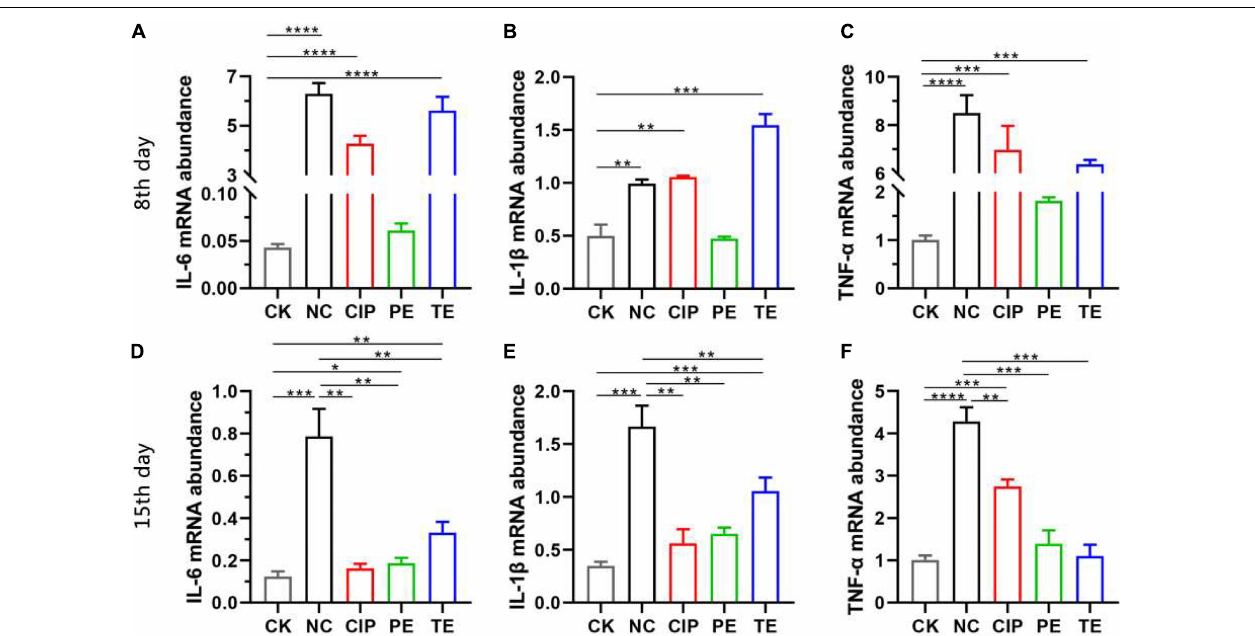
FIGURE 7 | The probiotic L. paracasei inhibit inflammation induced by diarrhea. (A–C) Representative the expression of IL-6, IL-1 β and TNF- α in ileum at day 8 after E. coli O 8 determined using RT-PCR in mice. (D–F) Representative the expression of IL-6, IL-1 β and TNF- α in ileum at day 15 after ciprofloxacin, E. coli O8 and L. paracasei administrated using RT-PCR in mice. * P < 0.05, ** P < 0.01, *** P < 0.001, **** P < 0.0001 as determined by Student’s t -test.